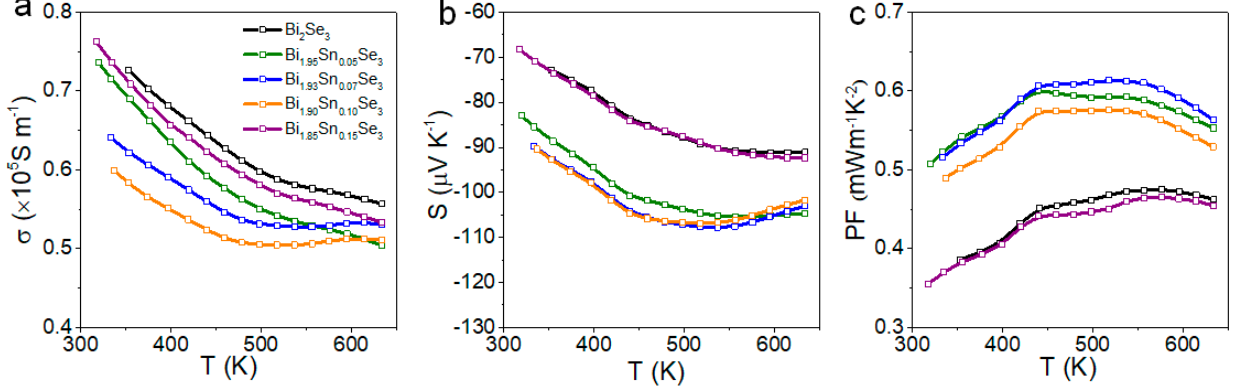
Figure 4. Thermoelectric properties of Bi 2 − x Sn x Se 3 perpendicular to the press direction: ( a ) electrical conductivity, σ ; ( b ) Seebeck coefficient, S ; ( c ) power factor, PF .